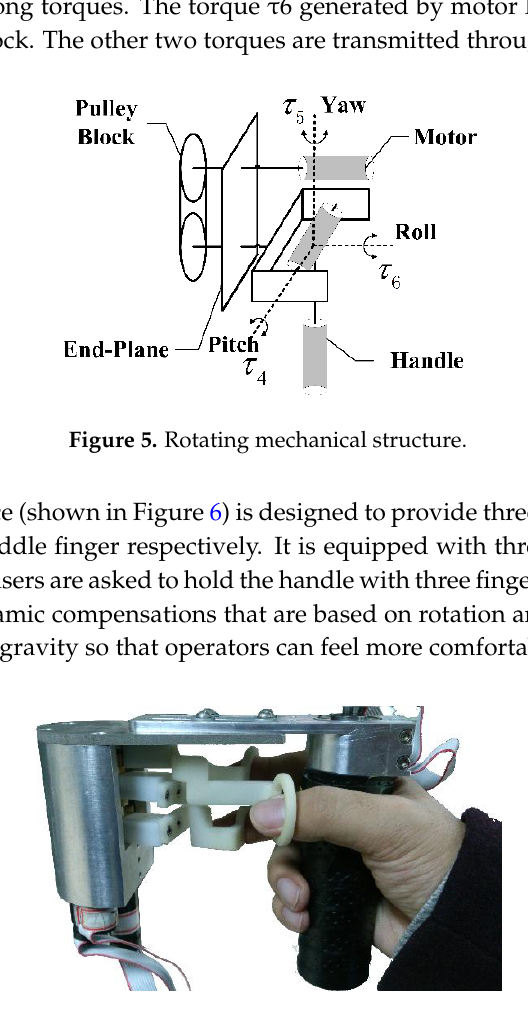
Figure 6. Grasping interface. Figure 6. Grasping